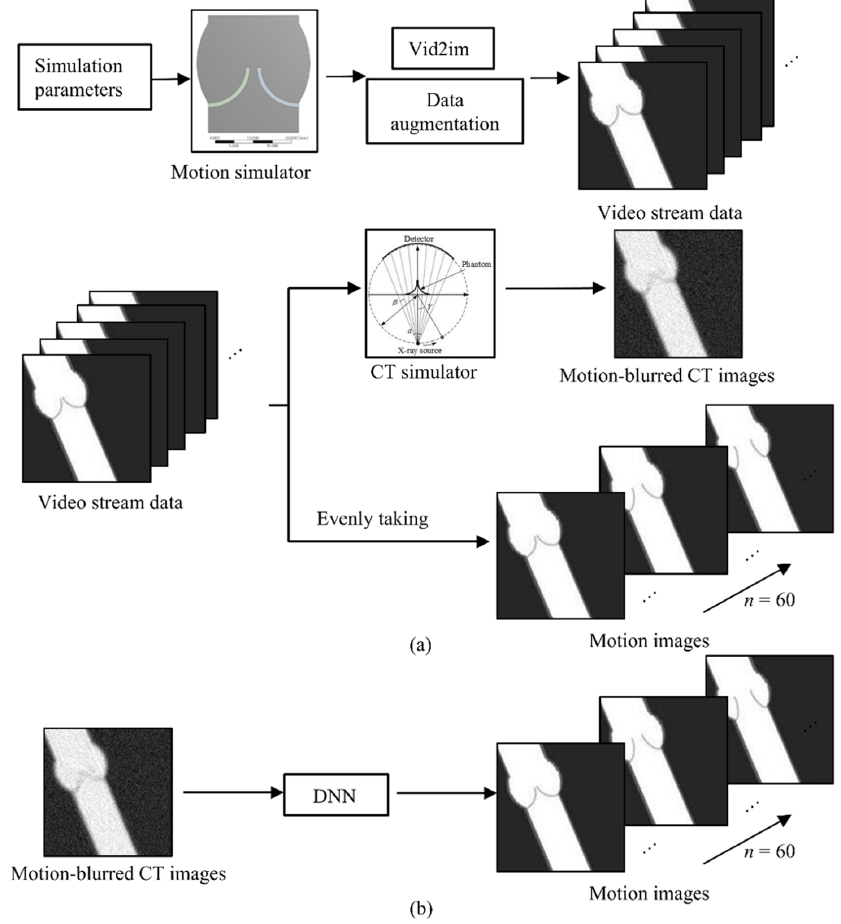
Figure 1. Overview of the proposed method. ( a ) Data generation process. First, various simulation parameters were input into the motion simulator to generate different motion videos. The videos were then converted to video stream data in the Vid2im module. The amount of video stream data was increased following data augmentation. Finally, motion ‐ blurred CT images were generated by the CT simulator using the augmented video stream data, and motion images were evenly taken from the video stream data used in CT imaging. ( b ) DNN training process. The DNN was trained using a dataset that included motion ‐ blurred CT images and their corresponding motion images.